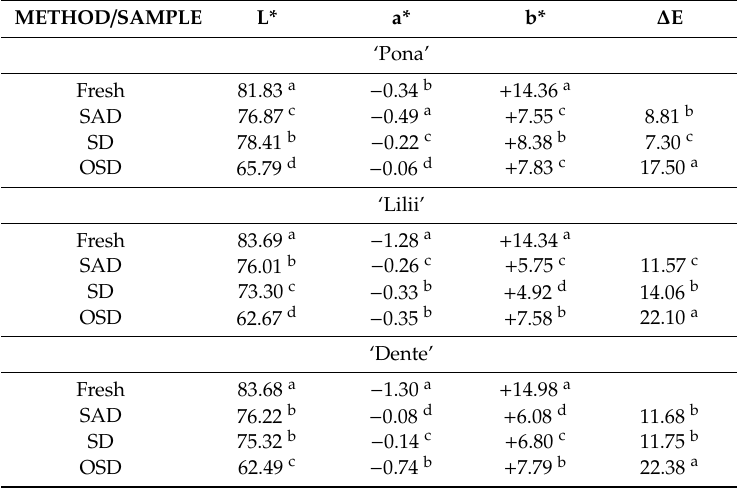
Table 4. Color measurement results for both fresh and dried yam of di ff erent